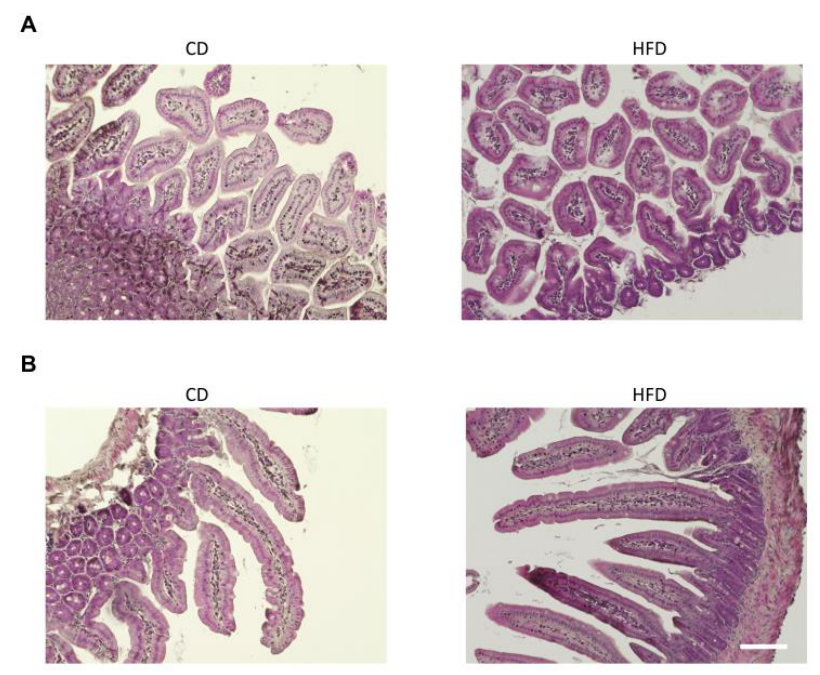
Figure 2. H&E staining of the upper ( A ) and lower ( B ) small intestines from HFD- and CD-fed mice. Scale bar: 100 μm.